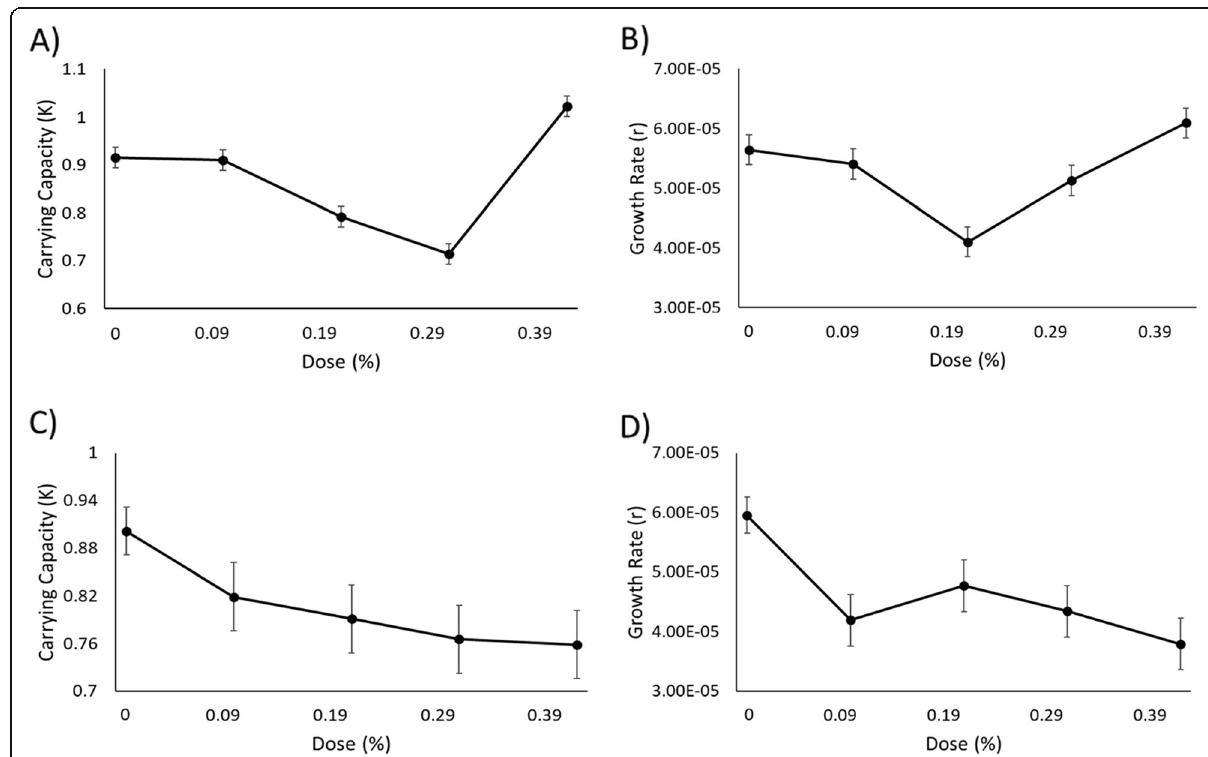
Fig. 2 Estimates of the population parameters of fungi species display the carrying capacity (left) in response to microdoses for C. albicans ( a ) and C. auris ( c ) and the intrinsic rate of growth (r) in response to dose for C. albicans ( b ) and C. auris ( d ). Doses correspond to the percentage of arborvitae solution as indicated in Additional file 3: Table S1. Error bars are ±1